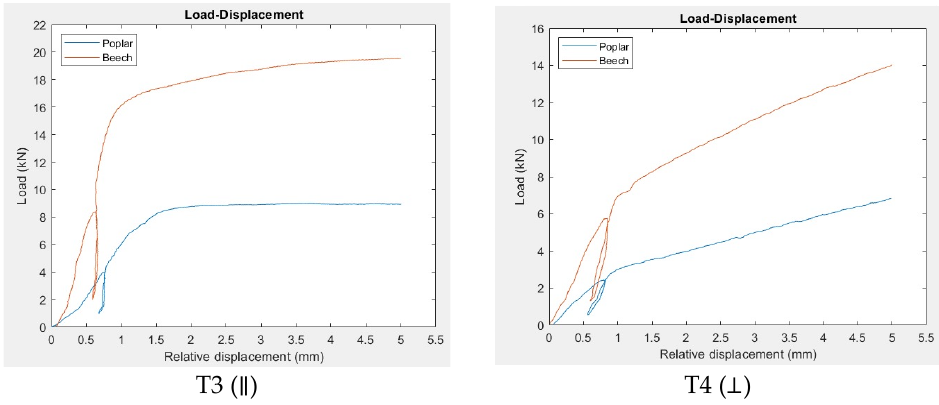
Figure 7. Comparison of load–displacement diagram between species for tests with bolts.